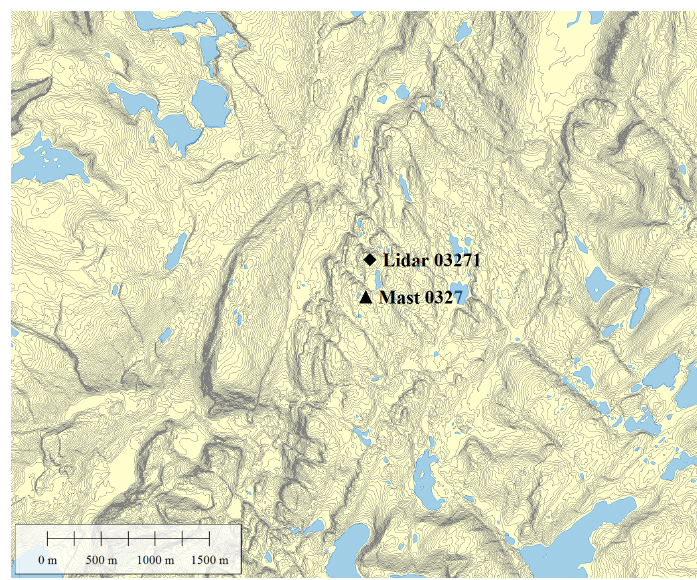
Figure 1. Map of the site with the position of the Lidar (64 ◦ 08 (cid:48) 20.7 (cid:48)(cid:48) N 10 ◦ 19 (cid:48) 04.0 (cid:48)(cid:48) E) and the meteorological mast (64 ◦ 08 (cid:48) 09.7 (cid:48)(cid:48) N 10 ◦ 19 (cid:48) 00.7 (cid:48)(cid:48) E). The height contours represent 5m height difference. Table 1. Instrumentation installed on the measurement mast. All cup anemometers are mounted on booms pointing southwest from the mast. At 100.5 m height, there is an additional cup anemometer on a boom pointing